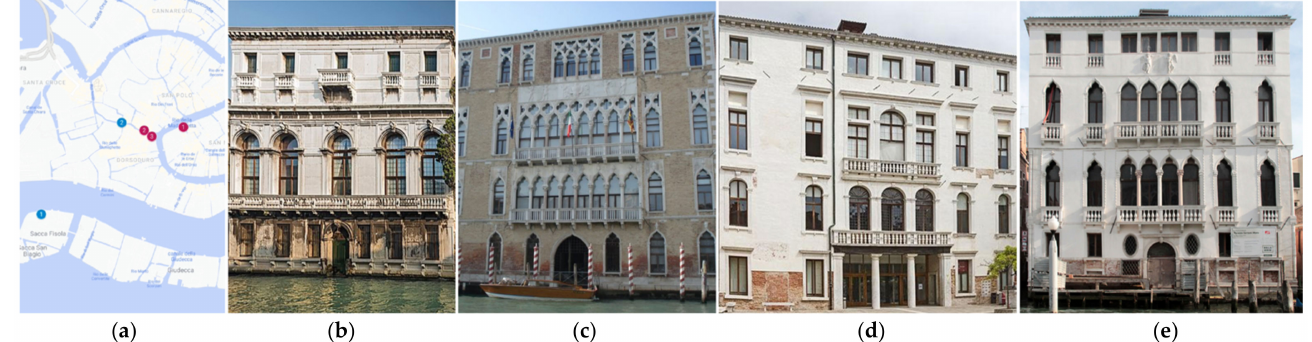
Figure 1. ( a ) Geographical location of the case studies (red dots) and of Sacca Fisola (blue dot 1) and Rio Novo (blue dot 2) meteorological stations; ( b ) Ca’Dolfin façade; ( c ) Ca’ Foscari façade on Grand Canal; ( d ) Ca’ Foscari internal courtyard; ( e ) Garzoni Palace façade.